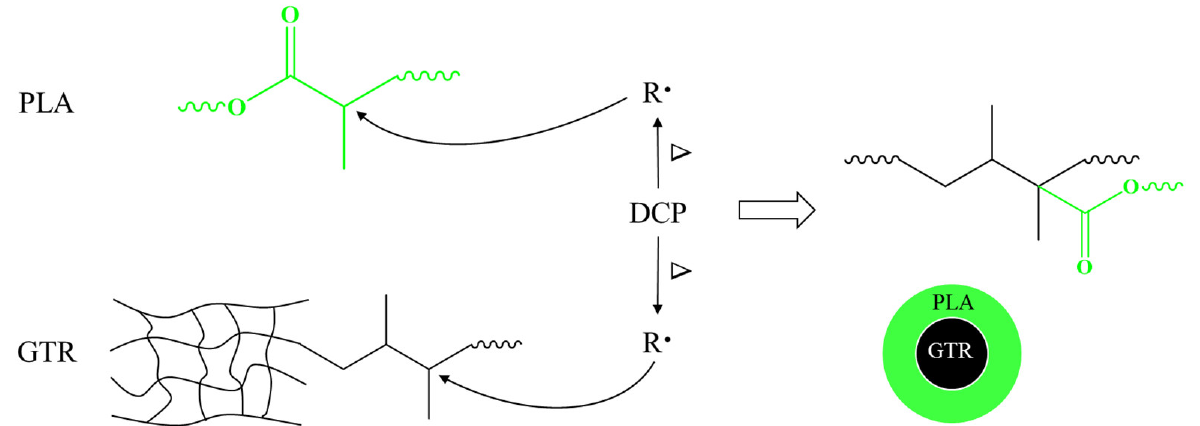
Figure 3. Schematic diagram of the possible interfacial reaction between PLA and GTR.